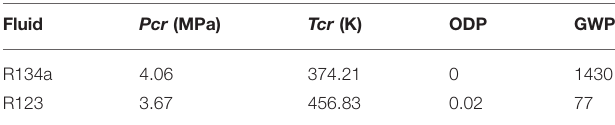
TABLE 1 | The property of working fluid.